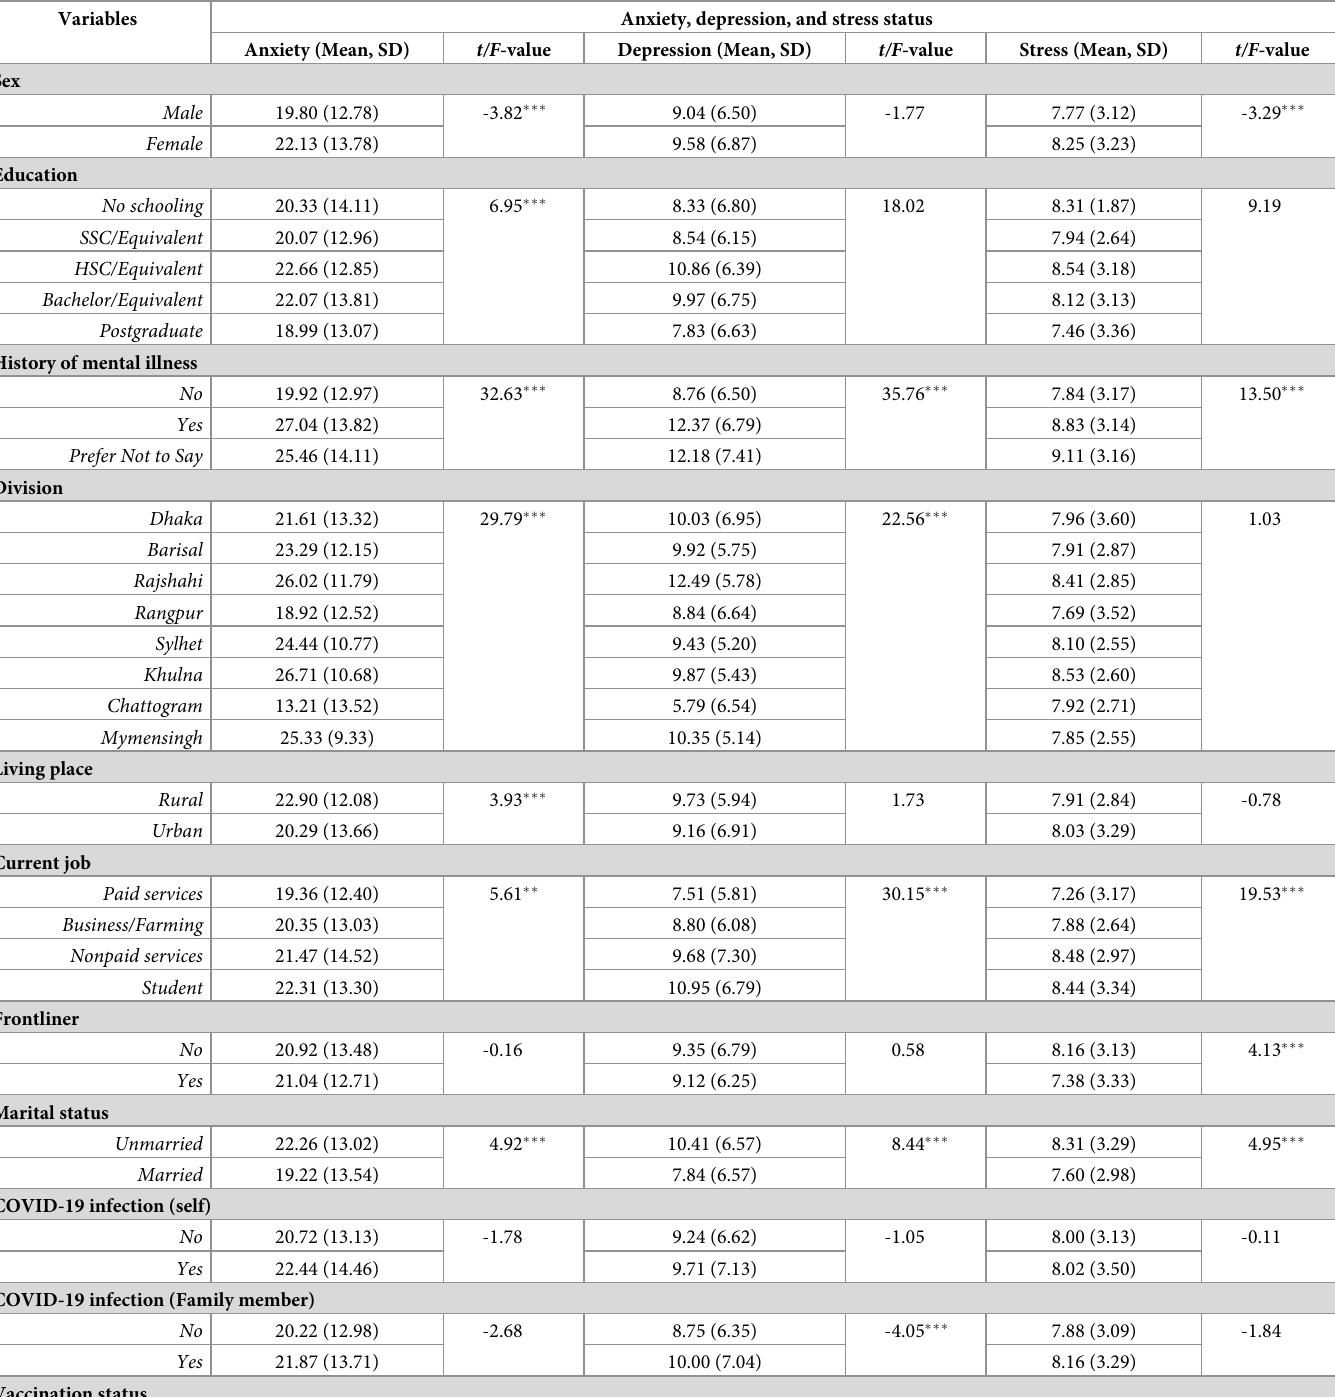
Table 2. Anxiety, depression, and stress of participants according to demographic variables and COVID-19 vaccination status ( N =